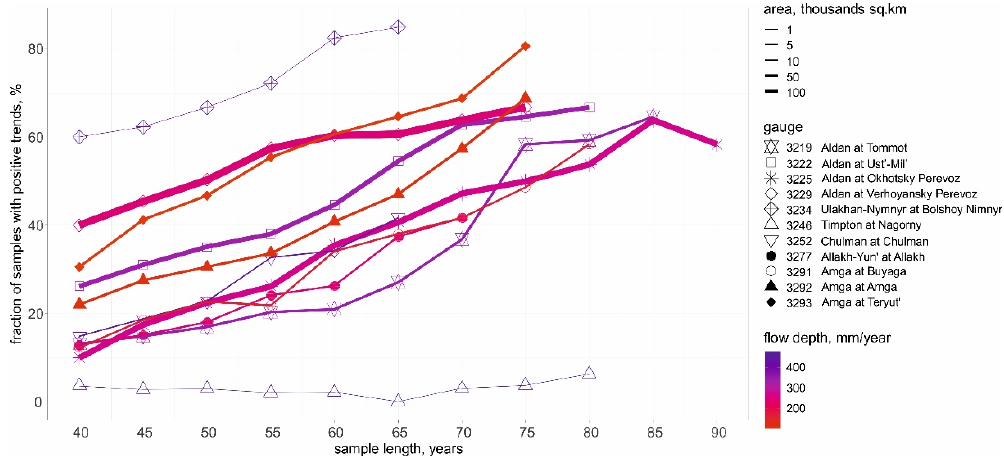
Figure 3. Fraction of samples with positive trends for every gauge for different sample lengths. The increasing fraction of series with positive trends as a function of sample length is characteristic for every gauge, except for Timpton R. at Nagorny (ID 3246), which has a fraction of samples with positive trends between 0 and 6.3% regardless of sample length. At Ulakhan-Nymnyr R. at Bolshoy Nimnyr (ID 3234), the fraction of samples with positive trend rises from 60 to 85% with sample lengthening from 40 to 65 years. At other gauges, it increases from 10–40% to 40–80% with sample length increasing from 40 to 65–90 years. In most gauges, the identified trends have a prominent seasonality (Figure 4). June discharges do not increase at any gauge. Additionally, 10% or less of all analyzed samples show positive trends in July, August and September. Upper Aldan (ID 3219, 3222) and Timpton (ID 3246) rivers show small number of positive trends in July (4–7%) followed by their absence in August. Chulman (ID 3252) and Amga (ID 3291, 3292, 3293) rivers have more positive trends in August (11–34%) than in July (5–29%). September streamflow is relatively stable at the Amga (ID 3291, 3292, 3293) and Aldan (ID 3219, 3222, 3225, 3229) rivers (<6% of samples with positive trends), but increases at the 39–51% of samples at the Chulman (ID 3252), Allakh-Yun’ (ID 3277) and Ulakhan-Nymnyr (ID 3234) rivers.